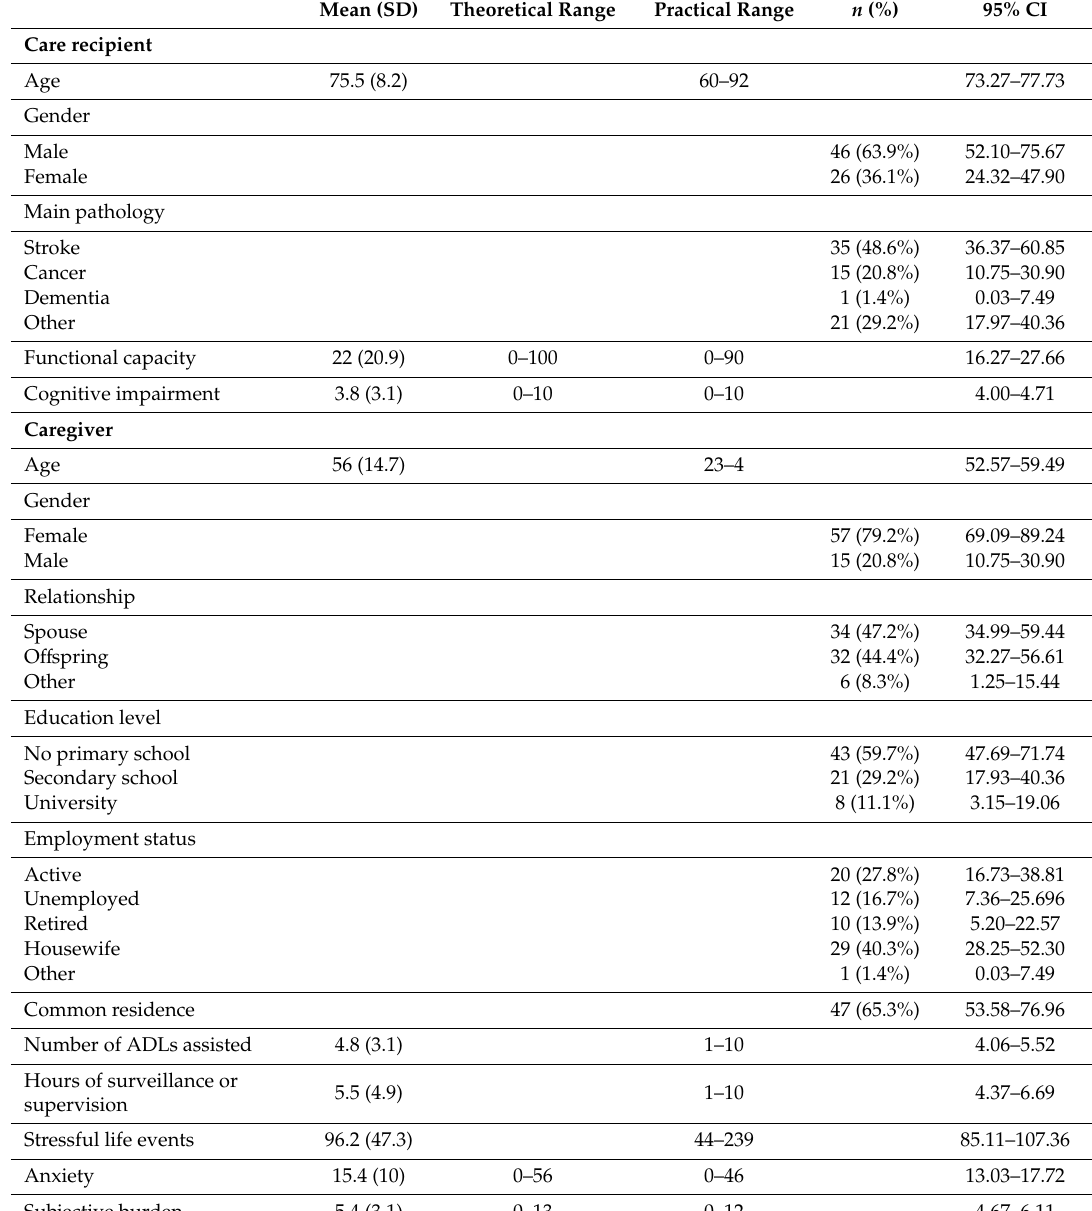
Table 1. Descriptive data of the sample characteristics and the variables used in this